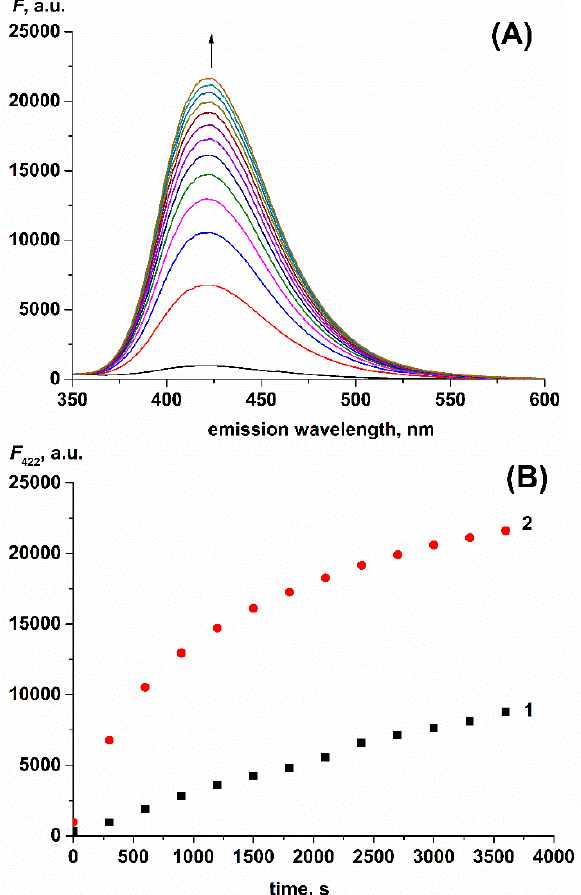
Figure 6. Fluorescence emission spectra of the mixture of terephthalic acid (1.0·10 − 3 M) with H 2 OCbl (1.0·10 − 6 M) and HSO 5- (5.0·10 − 4 M) were recorded every 5 min after mixing ( A ), and plots of fluorescence intensity at 422 nm versus time for mixtures of terephthalic acid (1.0·10 − 3 M) with HSO 5 − (5.0·10 − 4 M; Line 1) and with HSO 5 − (5.0·10 − 4 M) and H 2 OCbl (1.0·10 − 6 M; Line 2; B ) at pH 7.4, 25.0 °C.